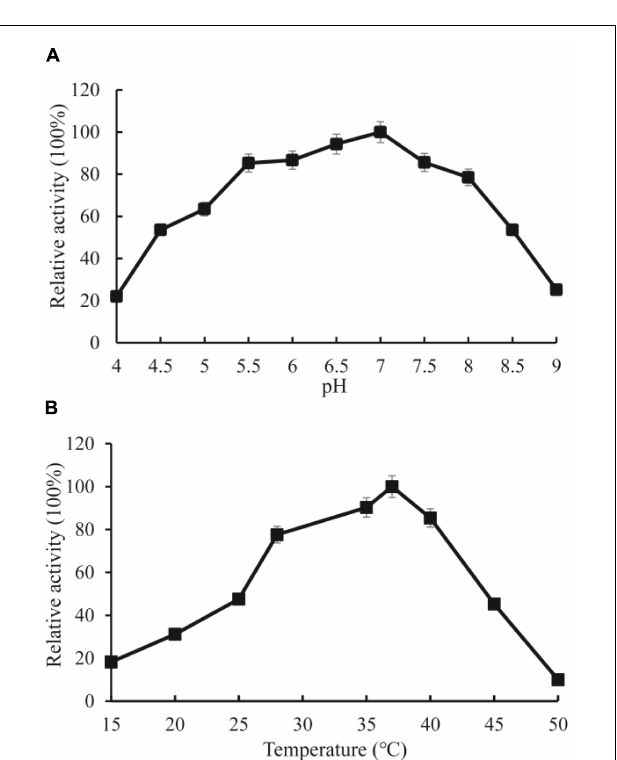
FIGURE 5 | Enzyme activity assays of OXC from M. mageritense (OXCmm). (A) Optimal pH of OXCmm activity. Different buffers were used for the different pH solutions in this assay. Sodium acetate buffer was used for pH 4.0–4.5; Phosphate buffer was used for pH 5.0 and 7.5; Tris buffer was used for pH 8.0. (B) Optimal temperature of OXCmm